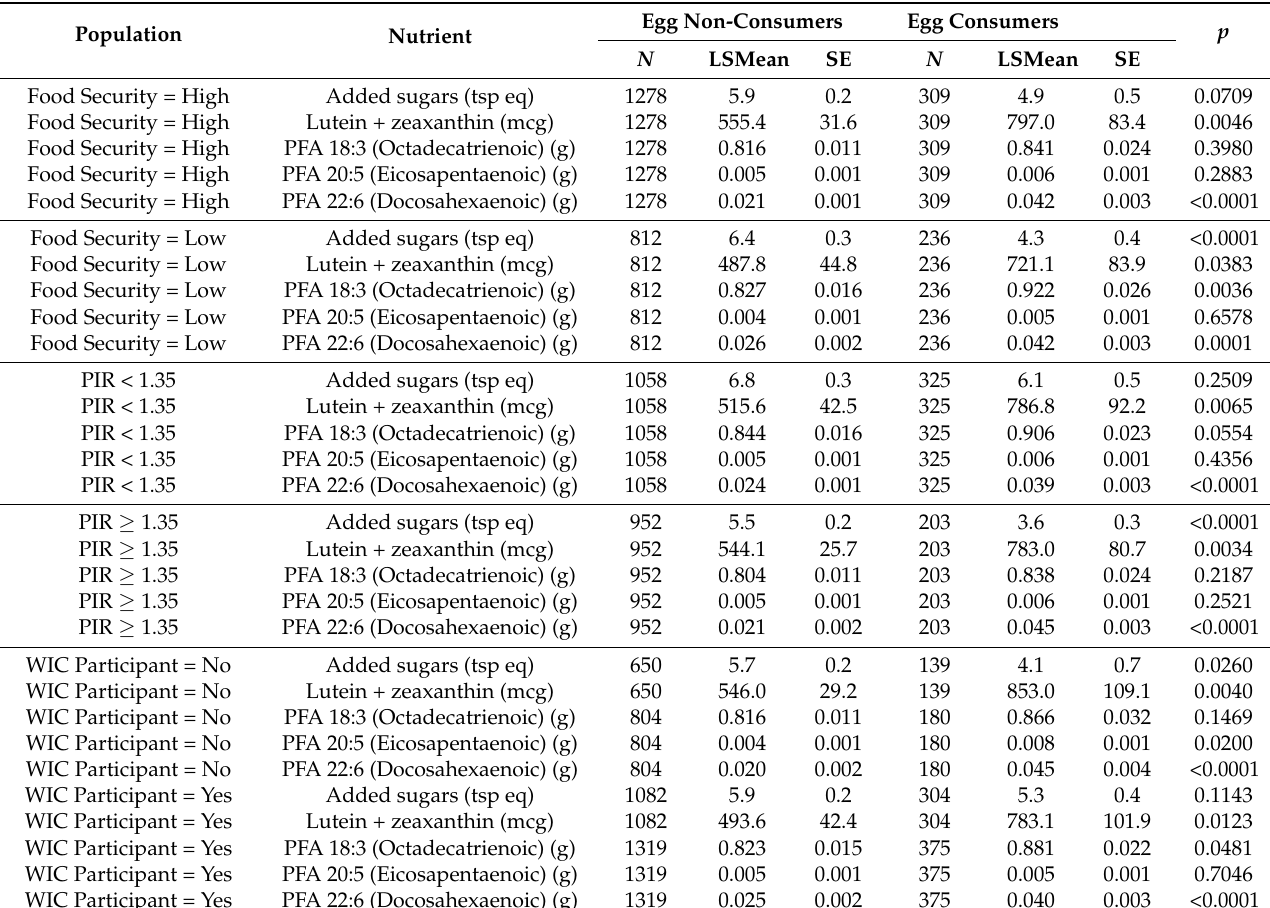
Table 4. Adjusted mean (SE), added sugar, lutein + zeaxanthin, octadecatrienoic acid, eicosapentaenoic acid, and docosahexaenoic acid based on socioeconomic measures for egg consumers vs. egg